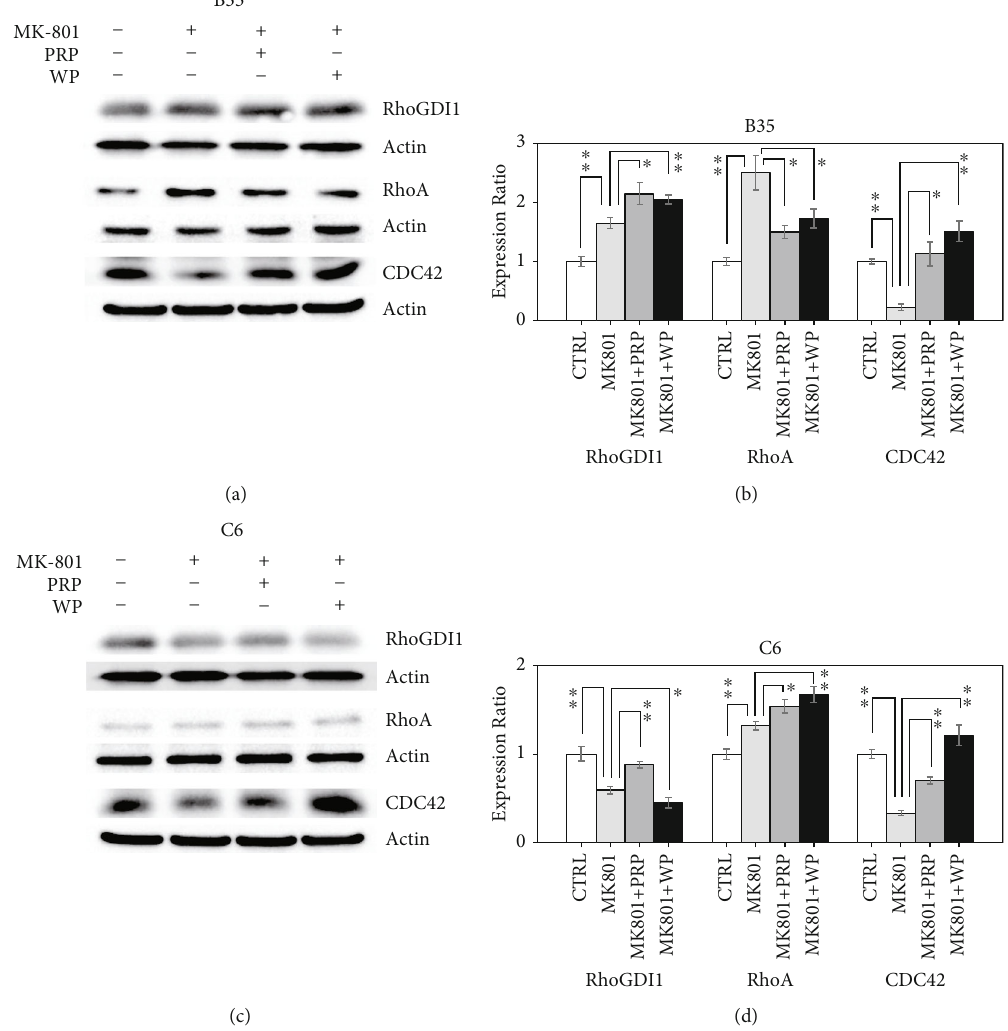
Figure 1: PRP and WP di ff erentially regulate MK-801-induced RhoGDI1, RhoA, and CDC42 regulation. Western blotting revealed the expression changes of RhoGDI1, RhoA, and CDC42 induced by PRP/WP in (a) B35 and (c) C6 cells treated with MK-801. The protein expression was quanti fi ed by using ImageJ software. Beta-actin was used as a normalization control to calculate the relative expression of the examined targets. The bar chart was constructed according to the data of three independent western blot experiments that analyzed three di ff erent batches of protein extracts of drug-treated (b) B35 and (d) C6 cells. The data was analyzed by using Student ’ s t -test ( ∗ p value < 0.05; ∗∗ p value < 0.01)